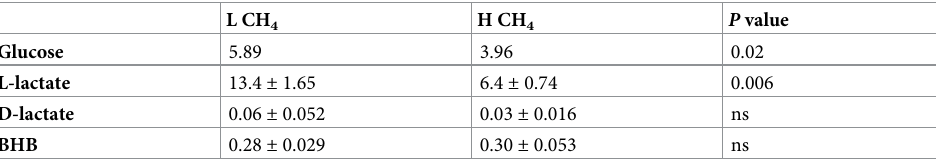
Serum samples were analysed for beta hydroxy butyrate (BHB), glucose and D-lactate and L- lactate. (Table 4; S2 Table). There were no significant effects liveweight. Glucose ( P = 0.02) and L-lactate was significantly higher ( P = 0.006) in the L CH phenotype. 4 Table 4. Blood metabolites (mM) of sheep related to quantitative differences in proteins of rumen epithelium in L (n = 8) or H (n = 8) CH 4 emitting sheep. (BHB; Beta-hydroxybutyrate). L CH 4 H CH 4 P